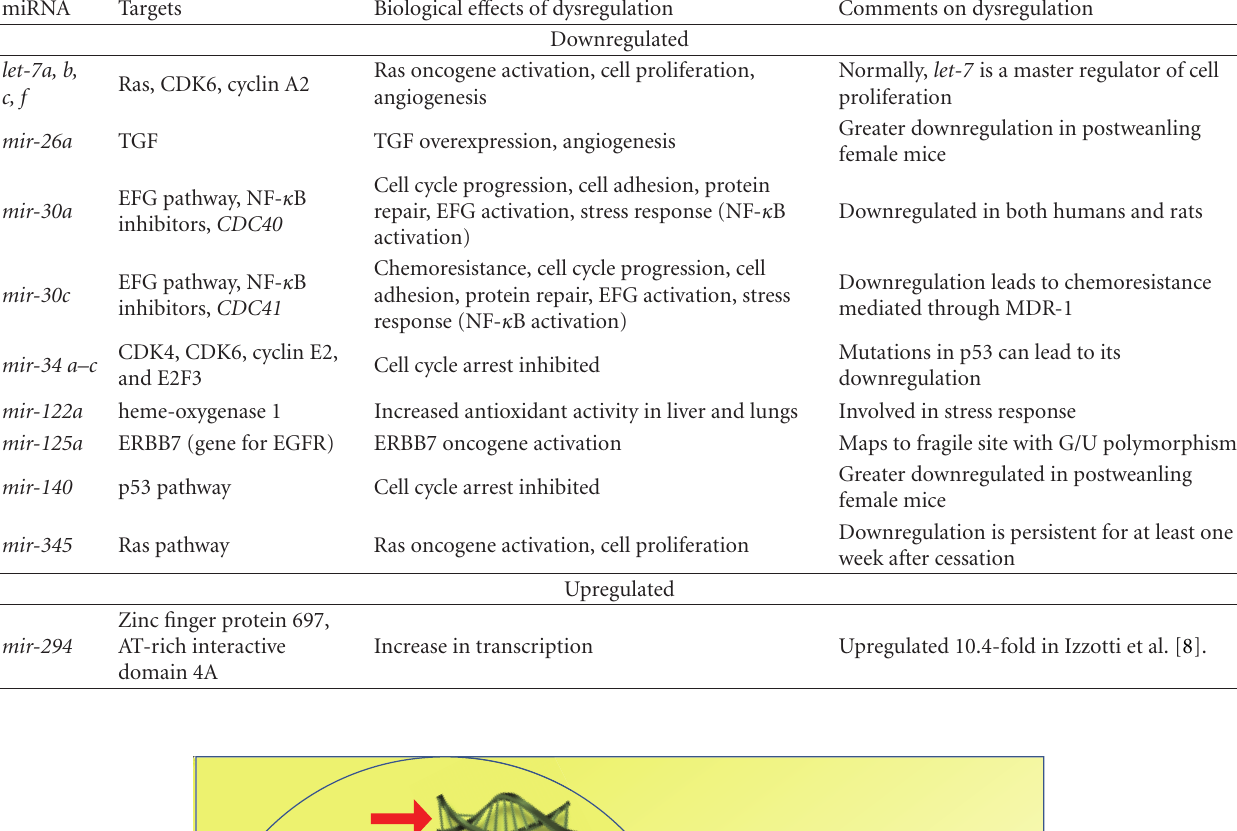
Table 1: Important miRNAs significantly dysregulated by cigarette smoke and implicated in carcinogenesis [8, 14, 32, 36]. miRNA Targets Biological e ff ects of dysregulation Comments on dysregulation